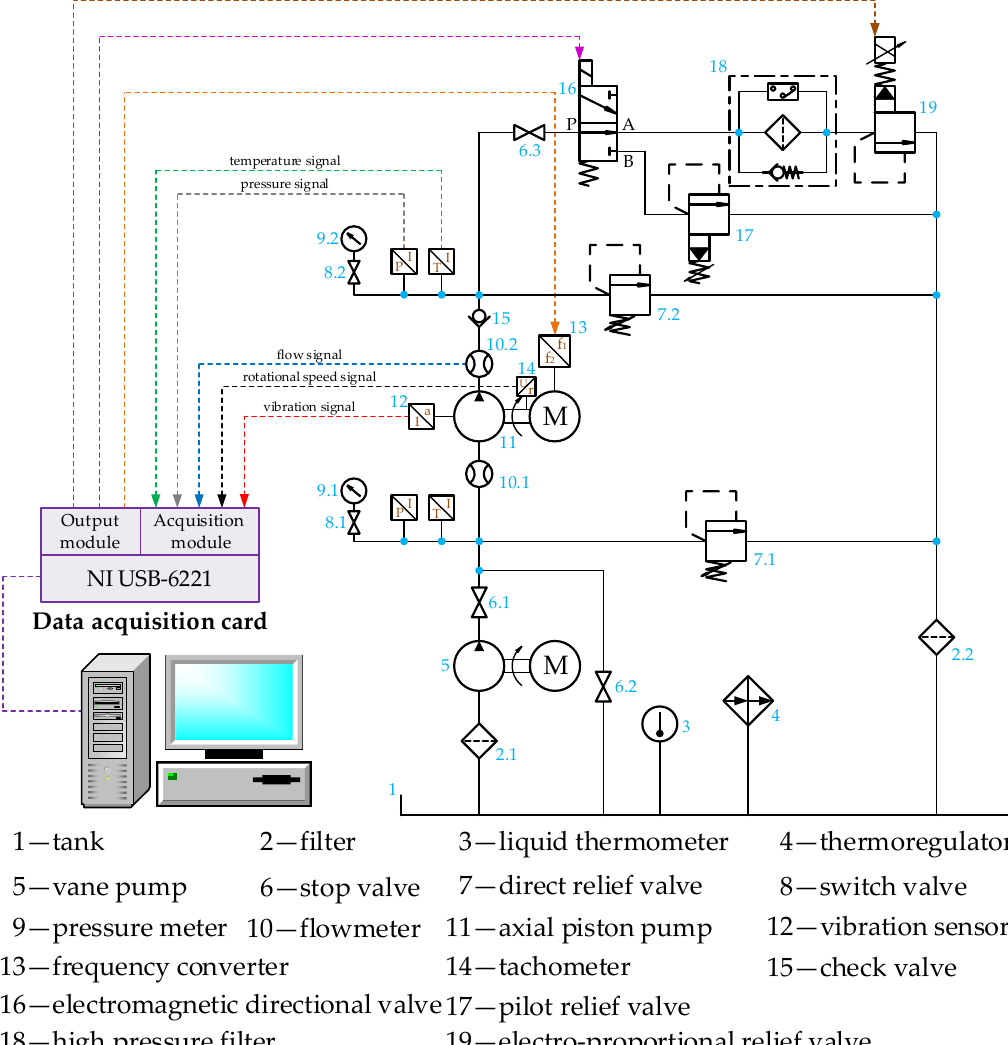
Figure 6. System schematic diagram for the degradation test of axial piston pump.